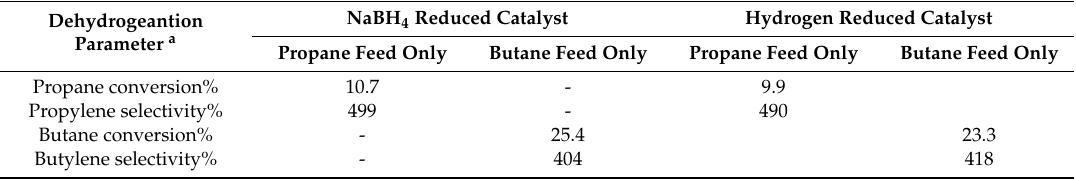
Table 2. Conversion and selectivity for individual para ffi n feed dehydrogenation after 240 min. NaBH 4 Reduced Catalyst Hydrogen Reduced Catalyst Dehydrogeantion Parameter a Propane Feed Only Butane Feed Only Propane Feed